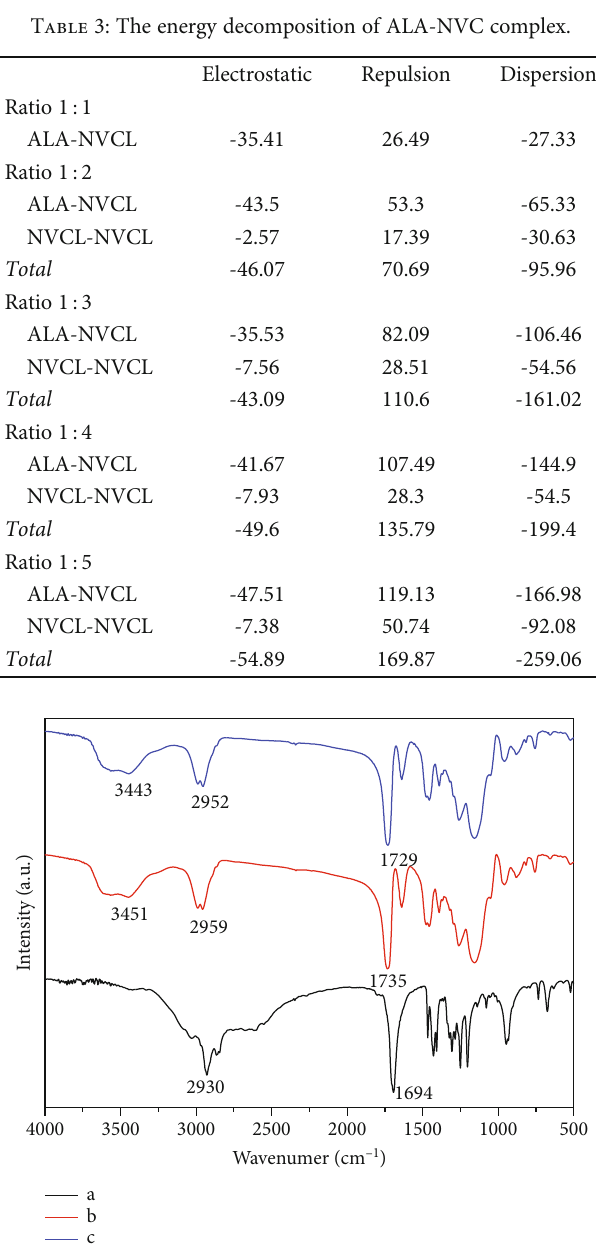
Figure 4: FT-IR spectra of MIPs (a), NIPs (b), and LA (c).